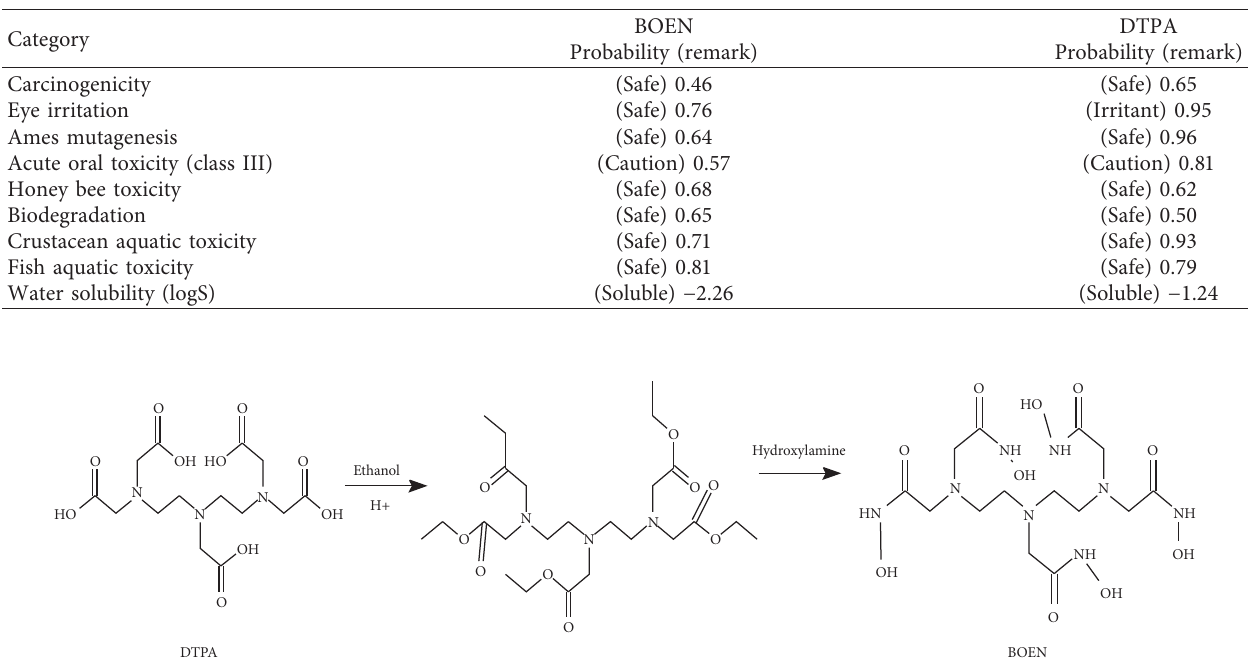
Table 7: Predicted ecotoxicity of the selected chemical and DTPA.